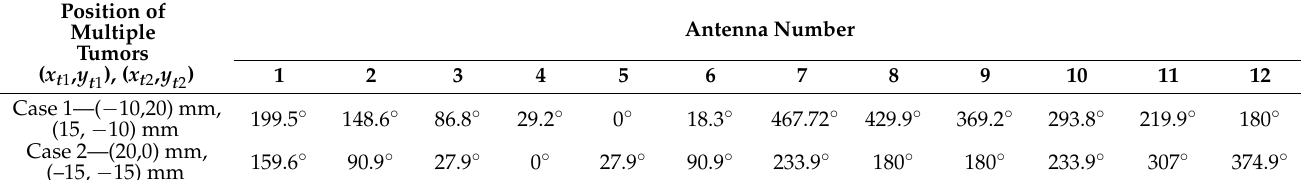
Figure 9. The 2D section of SAR distributions with the phase compensation technique depending on the values of the modified phase (black circles: tumor position): ( a ) 𝜑 𝑚 = 0° , ( b ) 𝜑 𝑚 = 60° , ( c ) 𝜑 𝑚 = 120° and ( d ) 𝜑 𝑚 = 180° .